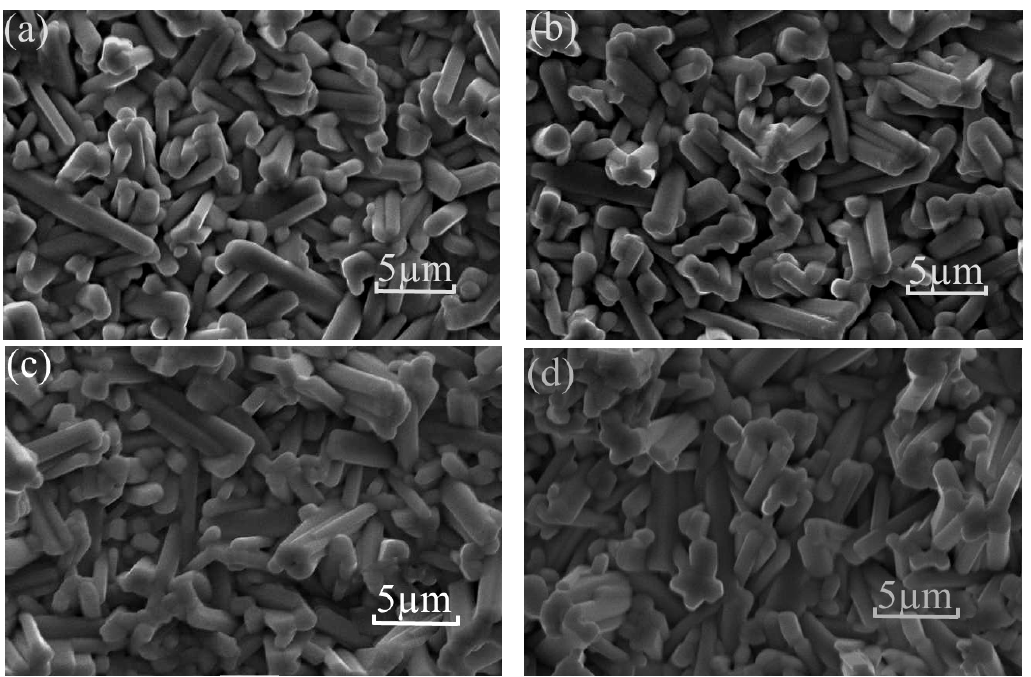
Fig. 5 SEM micrographs of (Ba 1 − x Sr x ) 4 (Sm 0.4 Nd 0.6 ) 28/3 Ti 18 O 54 ceramic for x = 0.08 sintered at various temperatures with (a) 1400 ℃ , (b) 1420 ℃ , (c) 1440 ℃ , (d) 1460 ℃ .